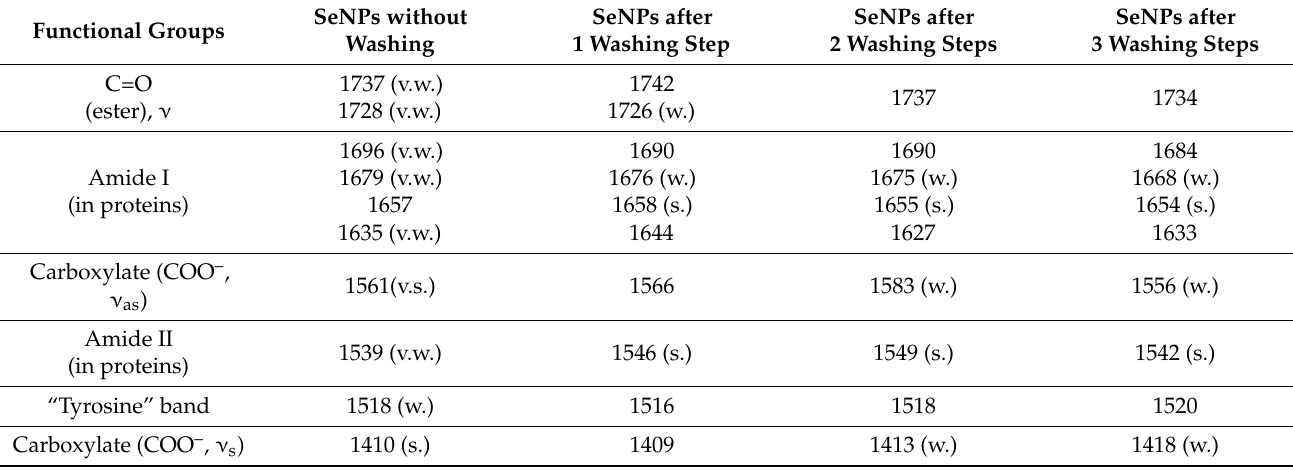
Table 2. Peak assignments 1 in second derivatives of FTIR spectra of biogenic SeNPs obtained using A. brasilense Sp7 measured without washing and after 1–3 washing steps (see Figure 6, curves A – D , respectively) [19–25,46–48]. Functional